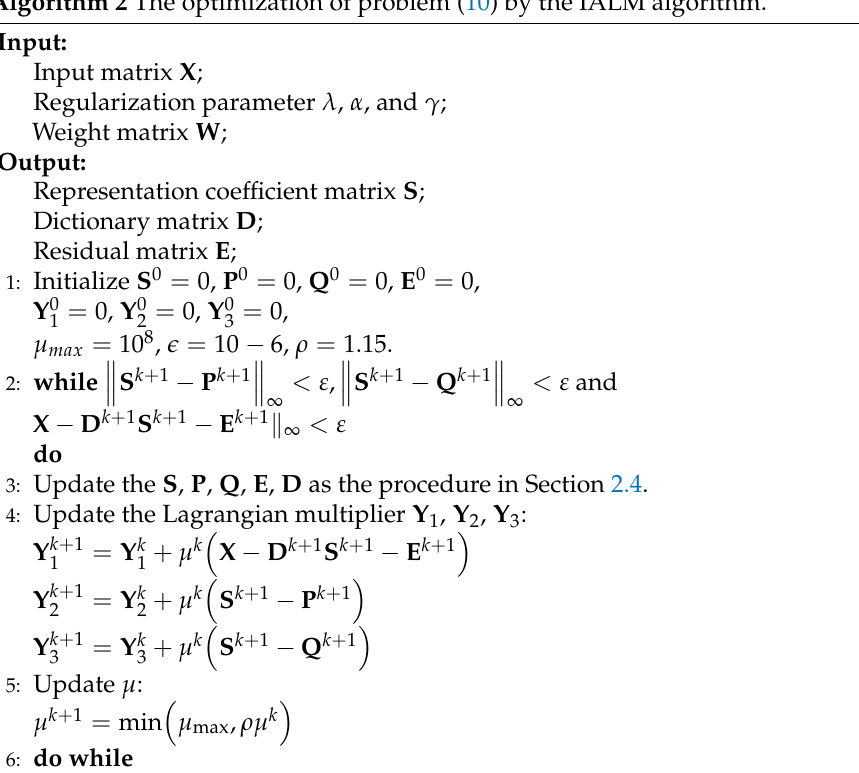
Algorithm 2 The optimization of problem (10) by the IALM